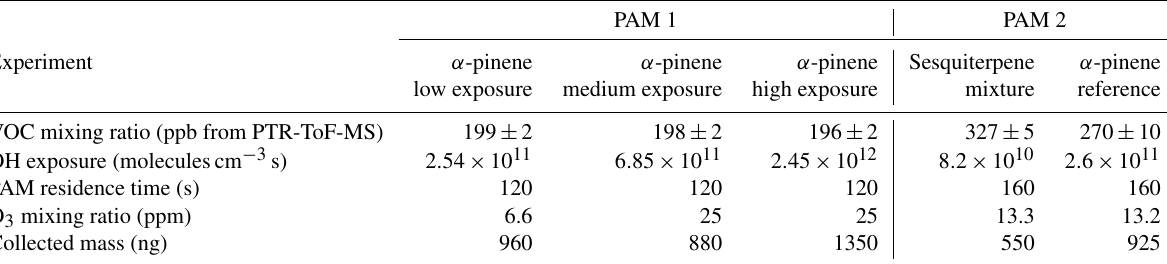
Table 2. List of different α -pinene and sesquiterpene experiments with corresponding PAM reactor conditions. Collected mass is estimated from SMPS data assuming a particle density of 1.3gcm − 3